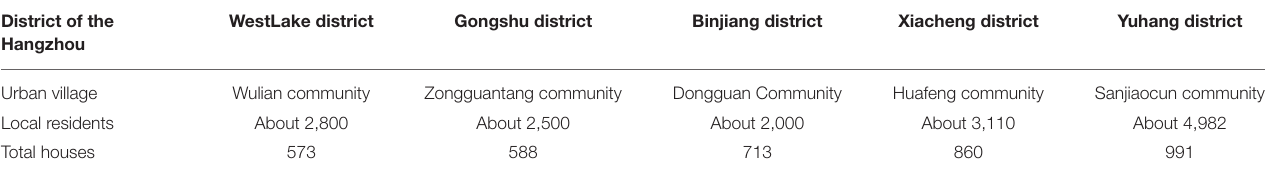
TABLE 4 | The urban village we